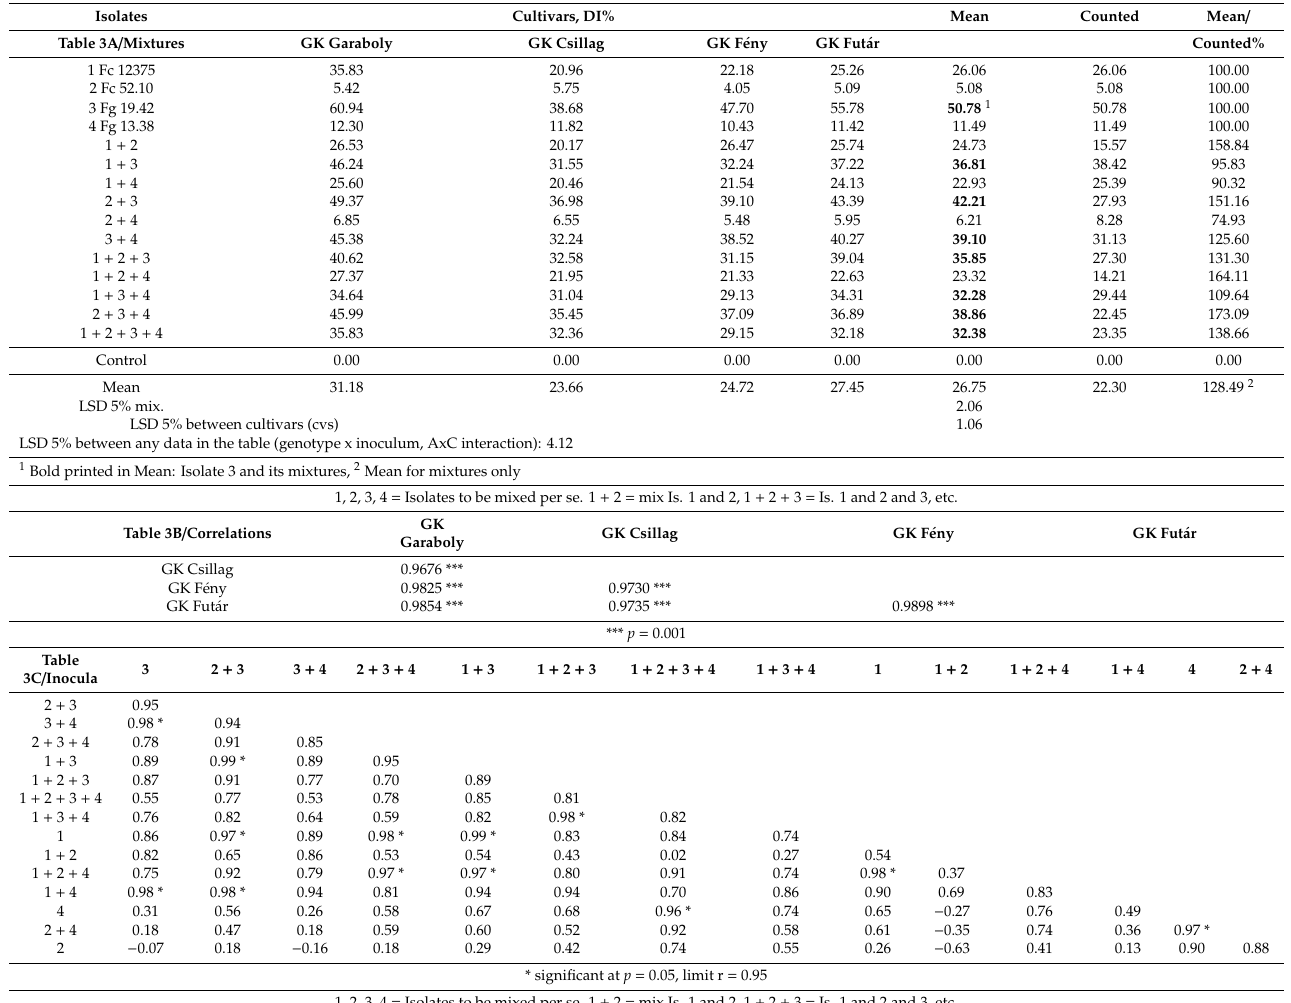
Table 3. Response of the wheat cultivars to the di ff erent isolates and their mixtures. Disease index data (%) across experiments, Szeged, 2013–2015. Isolates Cultivars, DI% Mean Counted Mean / Table 3A / Mixtures